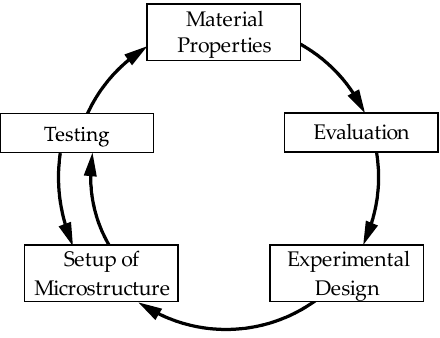
Figure 1. Schematic procedure of the method ‘Farbige Zustände’ [4].